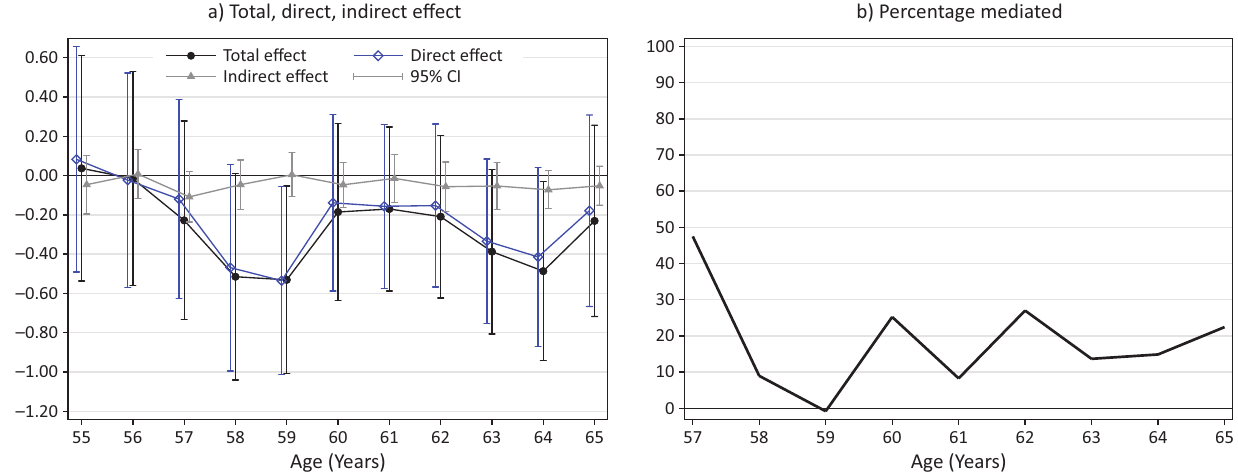
Figure A7. KHB mediation analysis of total, direct, and indirect effects of general versus vocational education on employ- ment probability (not) via health for men (net of double qualifications). Notes: Total and direct effect of general